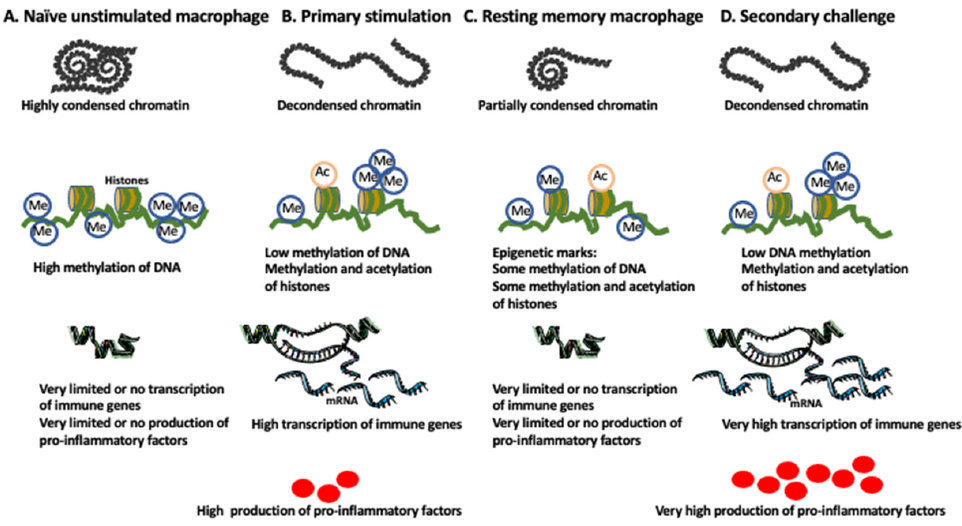
Figure 2. Chromatin structure and epigenetic marks during the development of memory macrophages. ( A ) In naïve (unstimulated) macrophages, the regions of chromatin housing the immune response genes are highly condensed (heterochromatin state) due to high methylation of DNA, making these genes inaccessible to the transcription factors. This results in complete silencing or very low transcription and translation of the immune response genes. ( B ) Primary stimulation with the pathogen or danger signals demethylates DNA, decondenses chromatin (euchromatin state), and methylates and acetylates histones (for example, H3K4me3, H3K27ac) reading the immune gene for transcription. A high level of transcription followed by translation produces a high level of immune response factors. ( C ) After cessation of the stimulus, chromatin only partially condenses, and the remaining epigenetic marks (for example, H3K4me1) keep resting memory macrophage in the state of transcriptional alertness. ( D ) The secondary challenge, with the same or different pathogen, induces chromatin decondensation, demethylation of DNA, and modification of histones (such as H3K4me3, H3K4me1, and H3K27ac) allowing robust transcription and subsequent high production of immune response factors. Modified from [54].